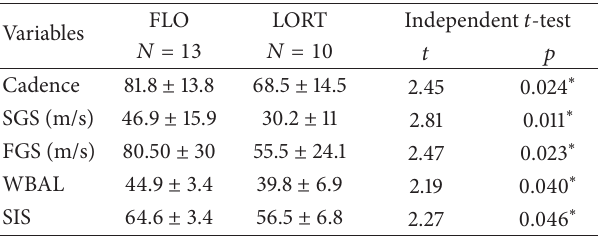
Table 5: Posttest between-group comparisons of the dependent variables.